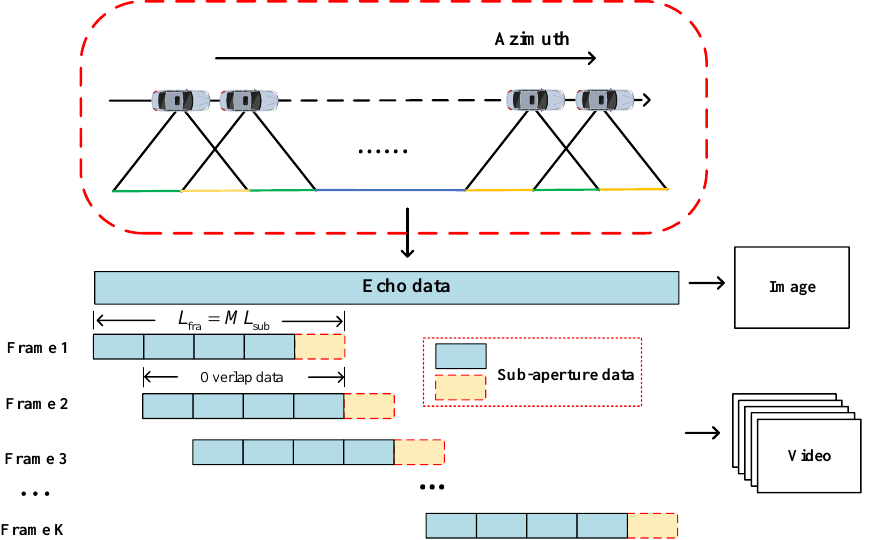
Figure 5. Implementation principle of automotive ViSAR with overlap.